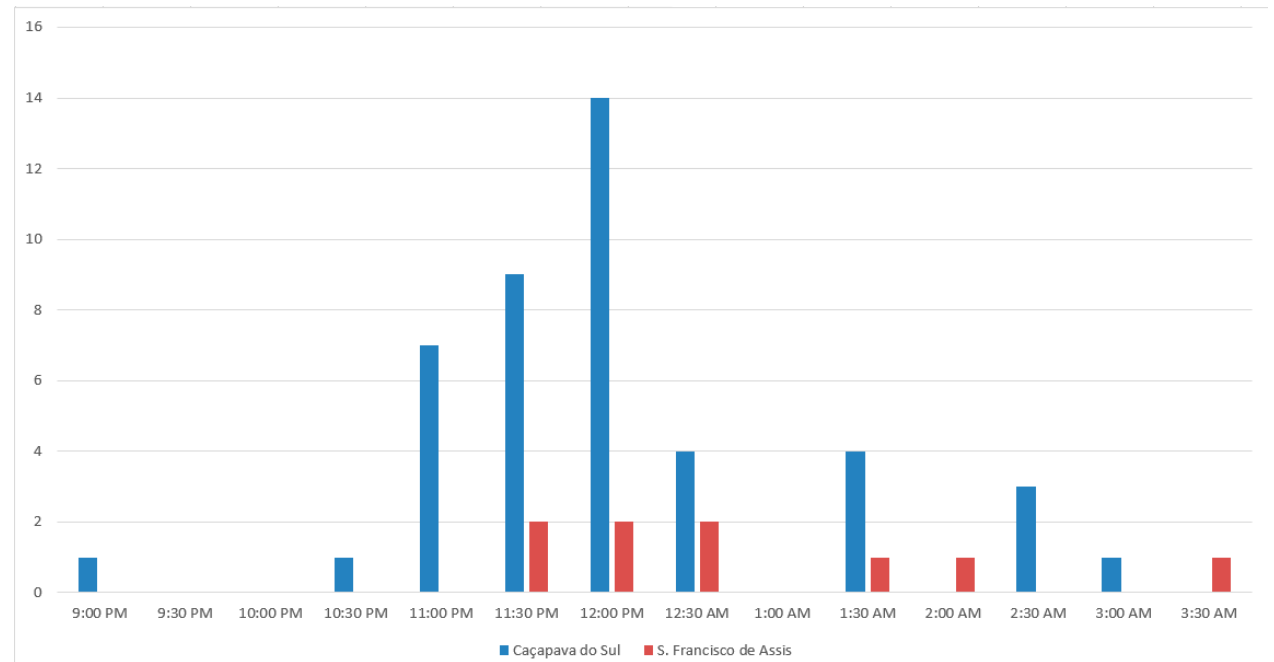
Figure 2. Hawk moths (Sphingidae, Lepidoptera) pollinating Cereus hildmannianus . ( a , b ) Hawk moths arriving with uncoiled proboscis. ( c – f ) Hawk moths entering the floral tube. ( c ) Eumorpha vitis . ( d ) Manduca sexta . ( e ) Eumorpha satellitia . ( f ) E. satellitia inside the floral tube.